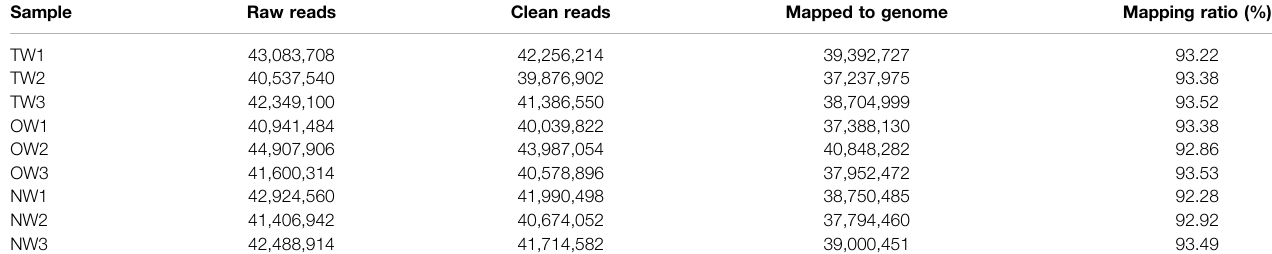
TABLE 2 | Summary of RNA-seq data from normal (NW), tension (TW), and opposite wood (OW). Sample